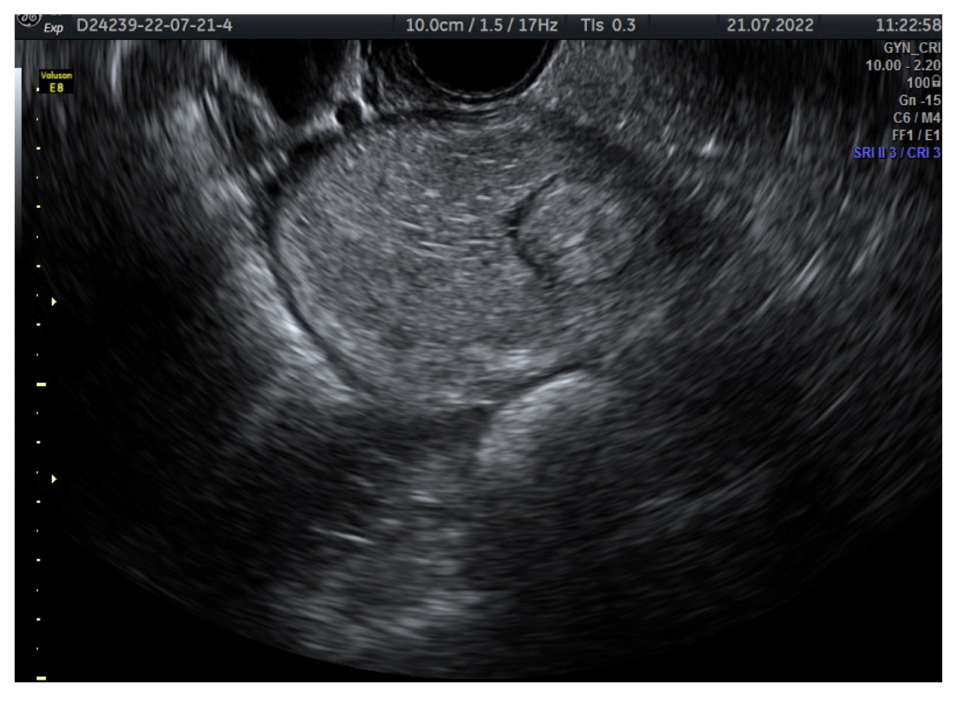
Figure 4. Transvaginal ultrasound of a mature teratoma. Echogenic foci or multiple hyperechoic lines are due to hairs